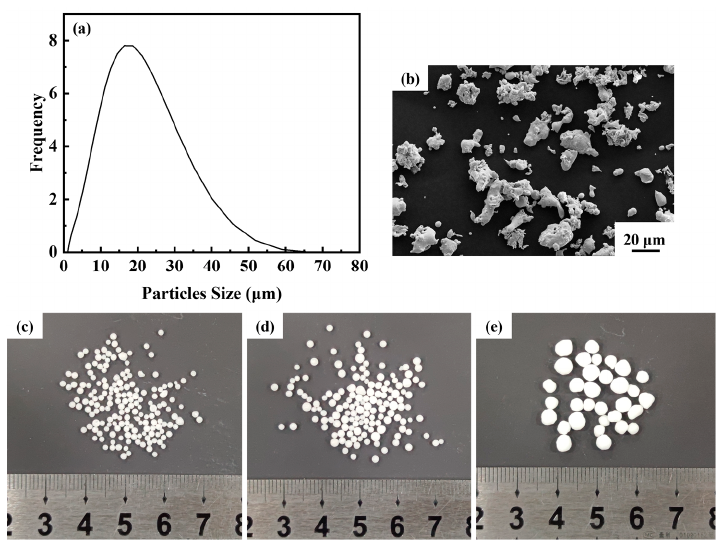
Figure 1. ( a ) Particle size distribution of steel powder; ( b ) microscopic morphology of steel powder; ( c – e ) urea particles of different size